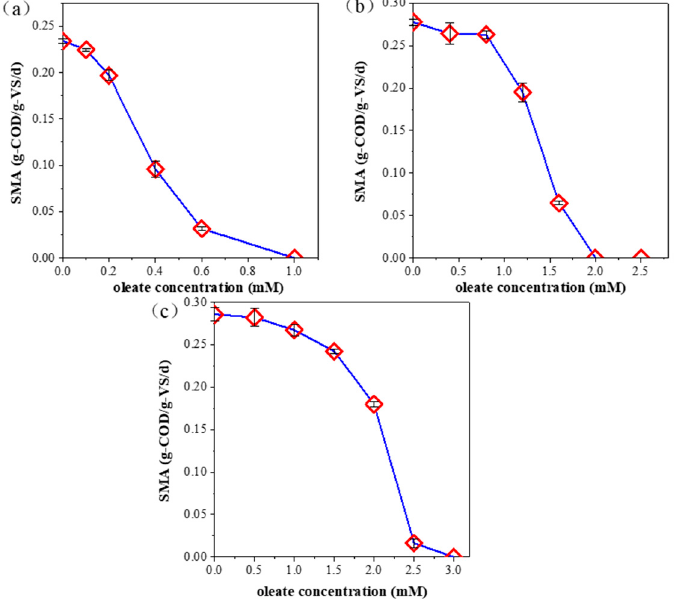
Figure 2. Effect of oleate concentration on SMA results: ( a ) acetoclastic SMA in mesophilic sludge, ( b ) hydrogenotrophic SMA in mesophilic sludge, ( c ) hydrogenotrophic SMA in thermophilic sludge.